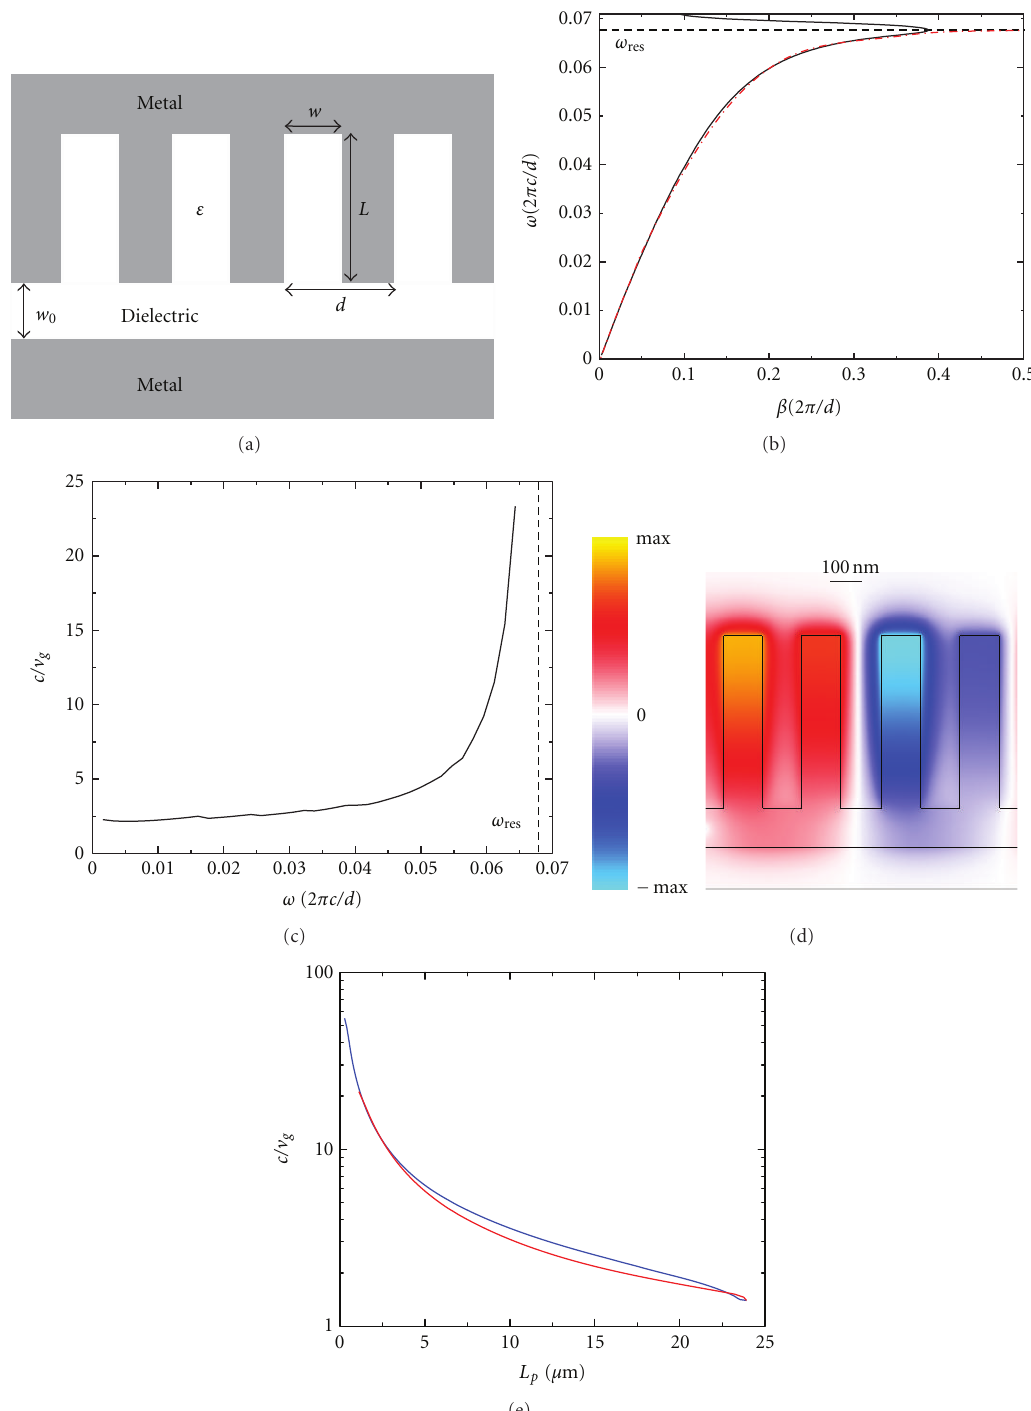
Figure 2: (a) Schematic of a plasmonic waveguide system consisting of a metal-dielectric-metal (MDM) waveguide side-coupled to a periodic array of MDM stub resonators. (b) Dispersion relation of the plasmonic waveguide system of (a) calculated using FDFD (black solid line). Results are shown for a silver-air structure with d = 100nm, L = 220nm, w 0 = w = 50nm. Also shown is the dispersion relation for lossless metal (red dash-dotted line) and the resonance frequency ω res (black dashed line) ( ω res ∼= 0 . 067 ∗ 2 πc/d corresponding to λ res ∼= 1 . 5 μm ). (c) Reciprocal of the group velocity v g of light in the plasmonic waveguide system as a function of frequency. All parameters are as in (b). (d) Magnetic field profile of the supported optical mode in the system at λ 0 = 1 . 55 μ m. All other parameters are as in Figure 2(b). (e) Reciprocal of v g versus propagation length L p for the plasmonic waveguide system of Figure 2(a) at λ 0 = 1 . 55 μ m calculated using FDFD. Results are shown for d = 100 nm (upper blue curve) and d = 200 nm (lower red curve) as L is varied. All other parameters are as in